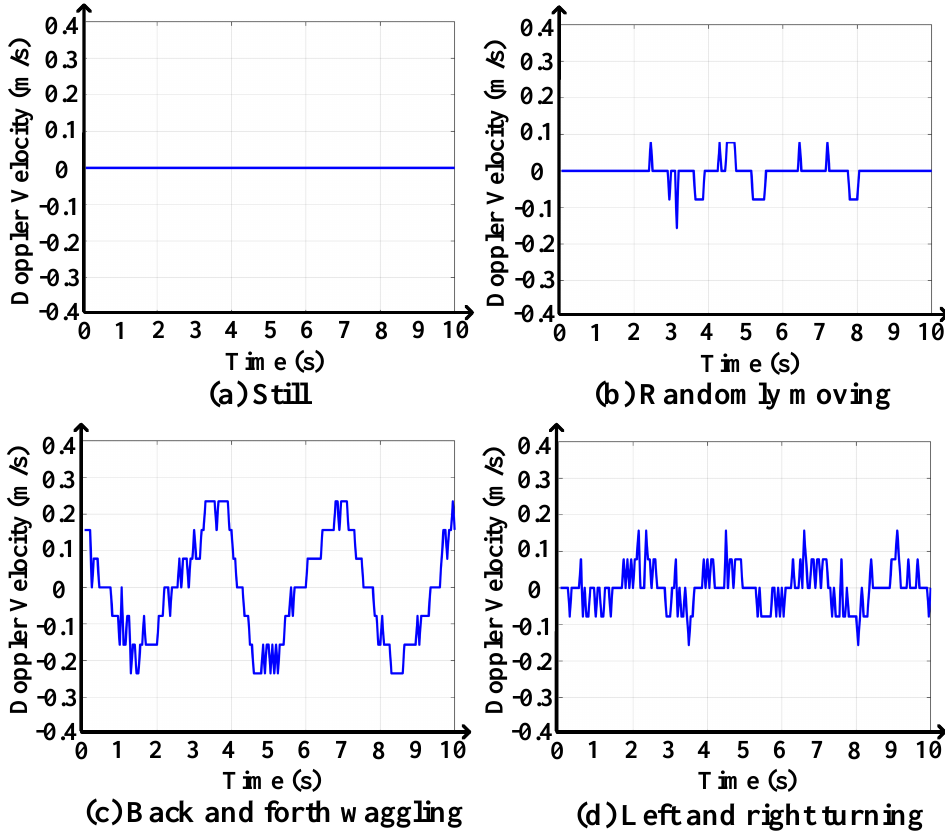
Figure 6. Doppler velocity for different body